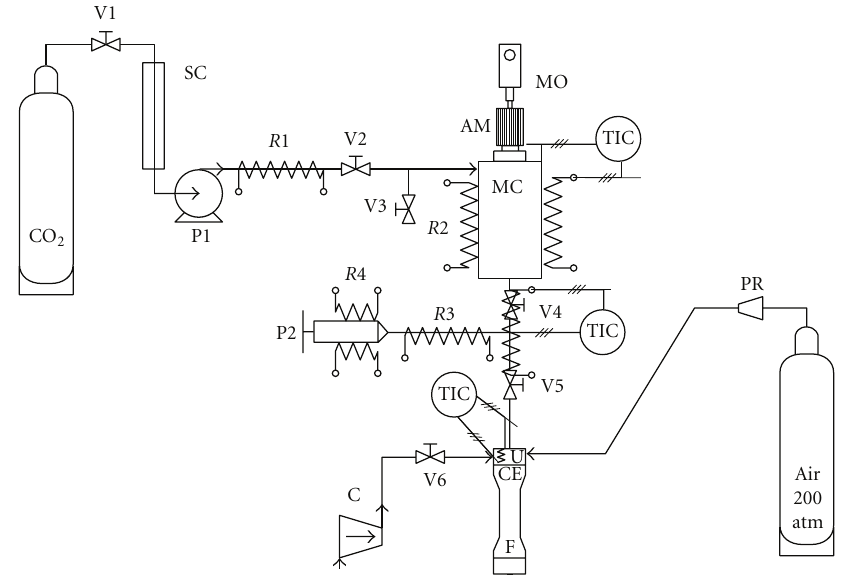
Figure 1: Schematic of the apparatus to carry out our modified-PGSS technique : MO, electric motor; AM, stirrer; MC, mixing chamber; U, nozzle; CE, expansion chamber; F, filter; R1, R2, R3, and R4, electric resistances; SC, heater exchanger; P1, pump; P2, manual syringe pump; V1, V2, V3, V4, V5, and V6, on-o ff valves; PR, pressure reducer; C, air compressor; TIC, temperature indicator and controller.